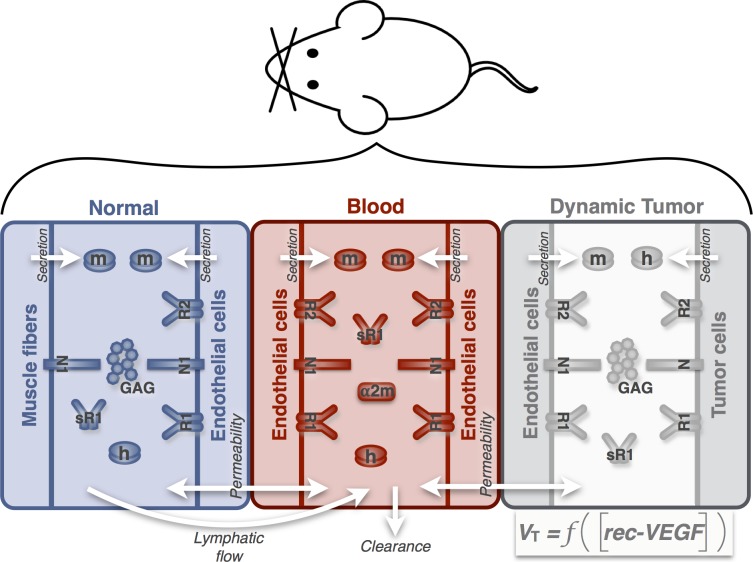
Model schematic.The computational model includes three compartments: normal tissue, blood, and tumor volume. The compartments are connected via lymphatic flow from the interstitial space in the normal tissue to the blood and transendothelial macromolecular permeability. Molecular species include human and mouse VEGF isoforms, VEGF receptors and co-receptors (including the soluble receptor VEGFR1, sR1), and the protease inhibitor α-2-macroglobulin (a2m). Glycosaminoglycan (GAG) chains represent the extracellular matrix. The volume of the tumor depends on the concentration of receptor-bound VEGF complexes on tumor endothelial cells (denoted as [rec-VEGF]).